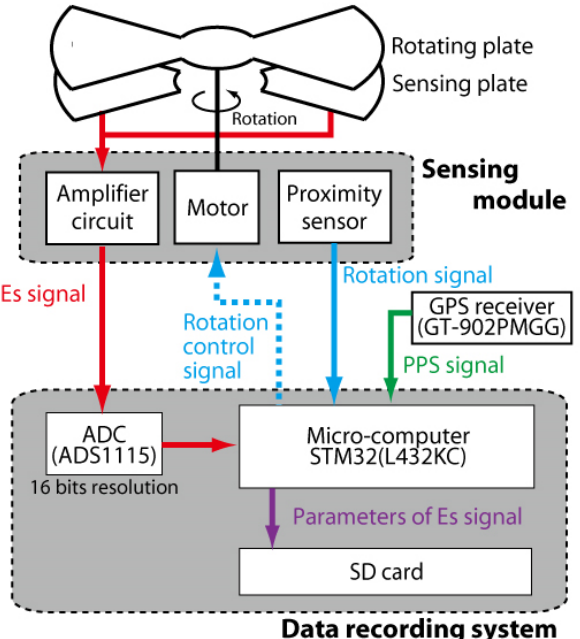
Figure 2. Block diagram of signal processing in our developed